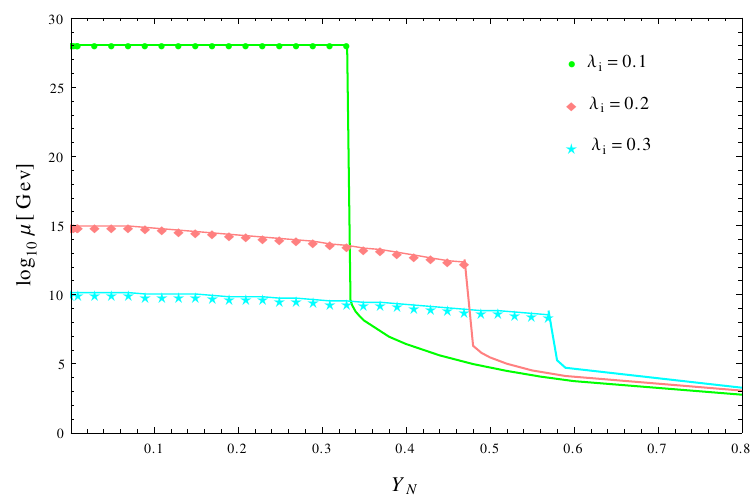
Figure 7 . E(cid:11)ect of Yukawa coupling on the perturbativity and stability bound for di(cid:11)erent values of (cid:21) i . (cid:21) i = 0 : 10 (green curve) ensures Planck scale perturbativity and stability for Y N (cid:20) 0 : 32. The pink curve corresponds to (cid:21) i =0.2 which gives Landau pole for Y N (cid:20) 0 : 47 (shown by diamond). After Y N = 0 : 47, the negative fermionic contribution starts dominating which makes the (cid:21) h (cid:20) 0 for 10 6 : 24 GeV (shown by pink line) before hitting the Landau pole. For (cid:21) i = 0 : 3, the running of (cid:12) (cid:21) hits the Landau pole till Y N (cid:20) 0 : 57 (described by cyan color star) and later the e(cid:11)ect of fermions makes the (cid:21) h (cid:20) 0 for 10 5 : 23 GeV (described by cyan